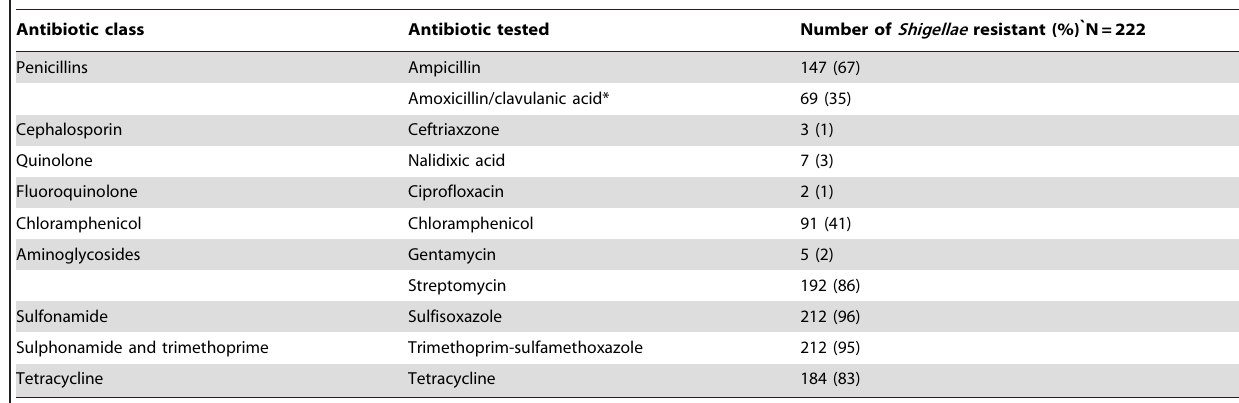
Table 3. Drug susceptibility patterns for Shigella isolated, Kibera,